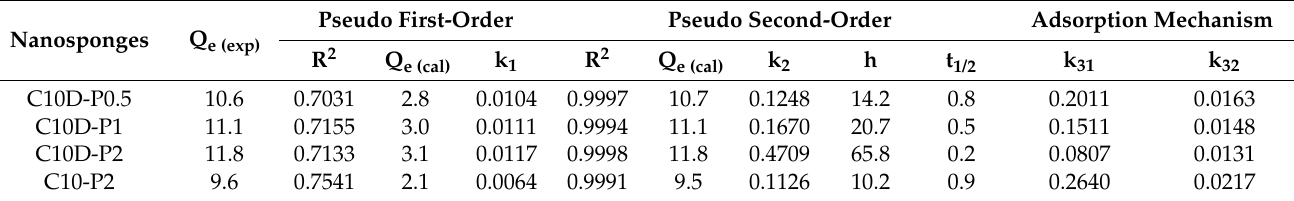
Table 2. Pseudo second-order and pseudo first-order kinetics parameters (conditions: 2 g/L of adsorbent dosage, 25 mg/L of PQ initial concentration, pH of 6.5, and temperature at 303